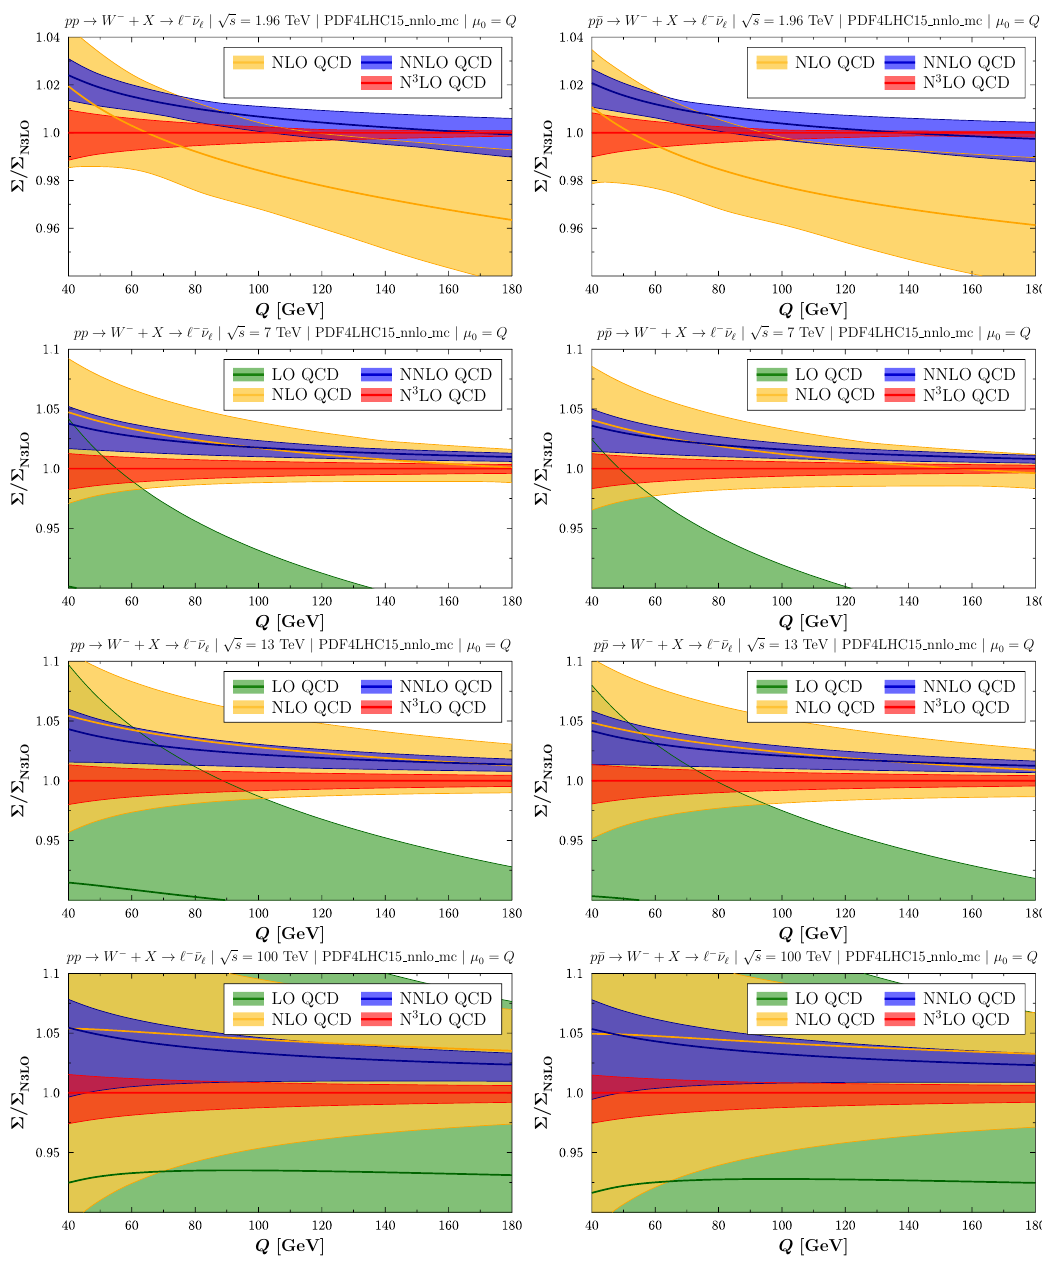
Figure 5 . Same as figure 3, but for W −